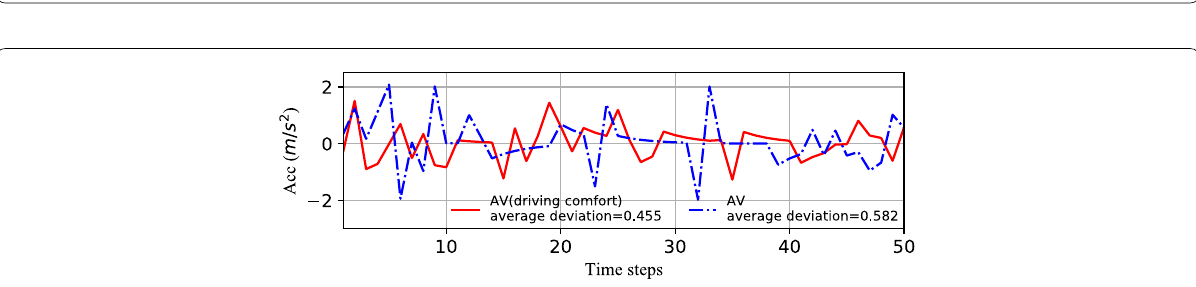
Figure 4 Performance comparisons between with and without actor-critic network sharing